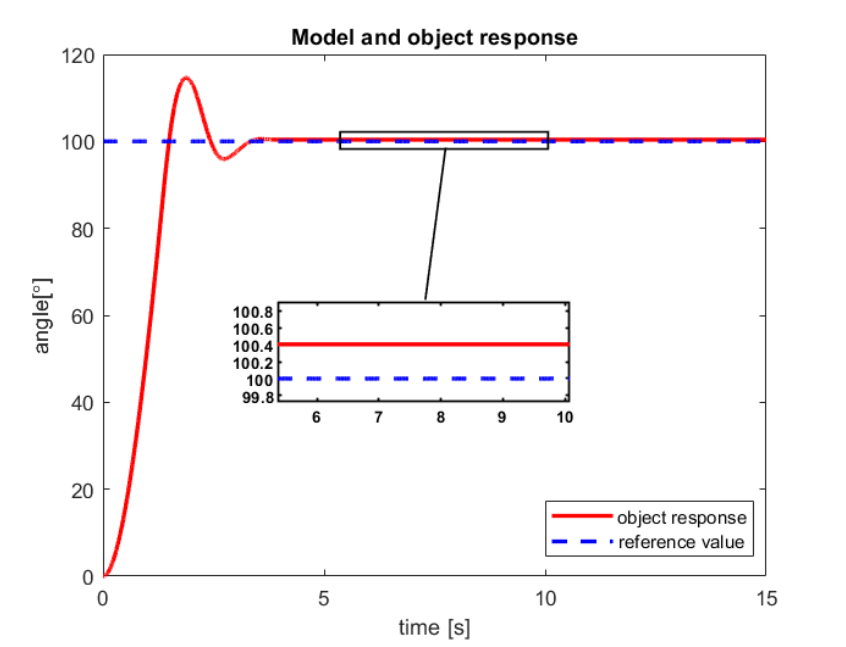
Figure 14. The received angular position of the the sensor-aided object for 100 ◦ reference value (source: authors).